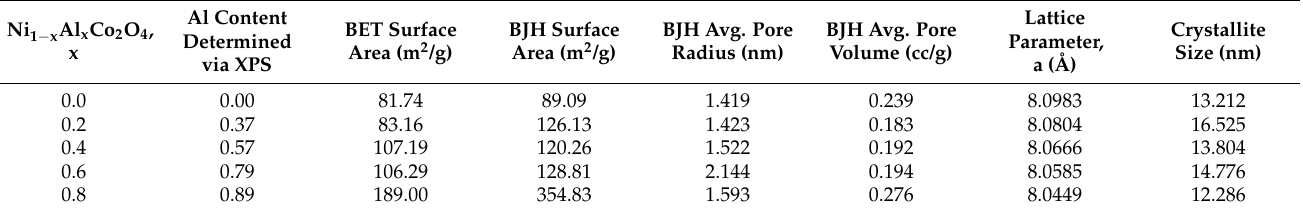
Table 2. Surface area parameters derived from the adsorption-desorption curve, crystallite size obtained using Scherrer’s formula, lattice parameter obtained from XRD refinement, and Al 3+ content was obtained from the XPS analysis of Ni 1 − x Al x Co 2 O 4 compound.